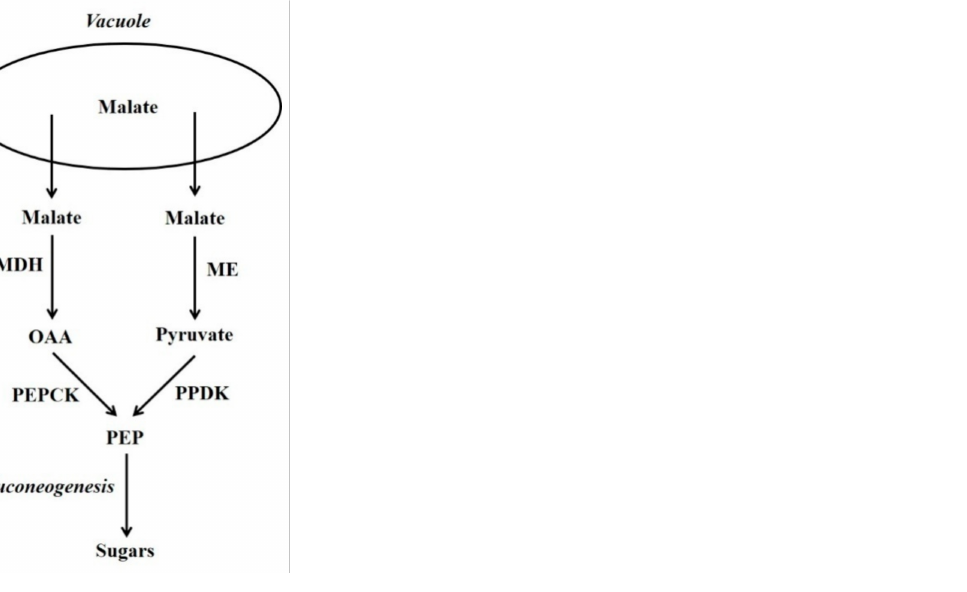
Figure 1. The PEPCK and PPDK gluconeogenesis pathways. OAA = oxaloacetate; PEP = phospho- enolpyruvate; MDH = malate dehydrogenase; ME = malic enzyme; PEPCK = phosphoenolpyruvate carboxykinase; PPDK = pyruvate orthophosphate